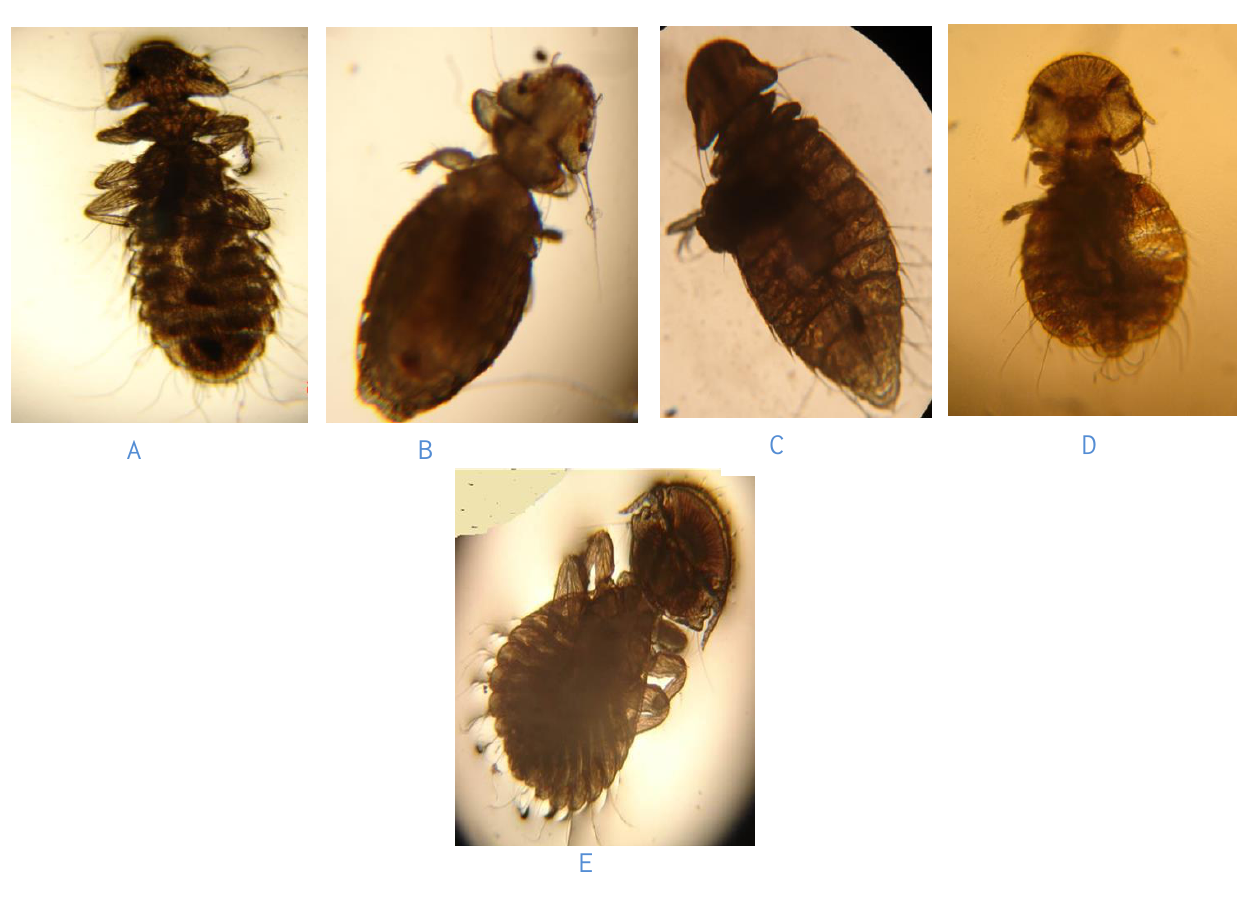
Figure, 1:- Lice species :- a Menacanthus stramineus , b. Cuclotogaster heterographus, C. Menopon gallinae , d. Goniocotes